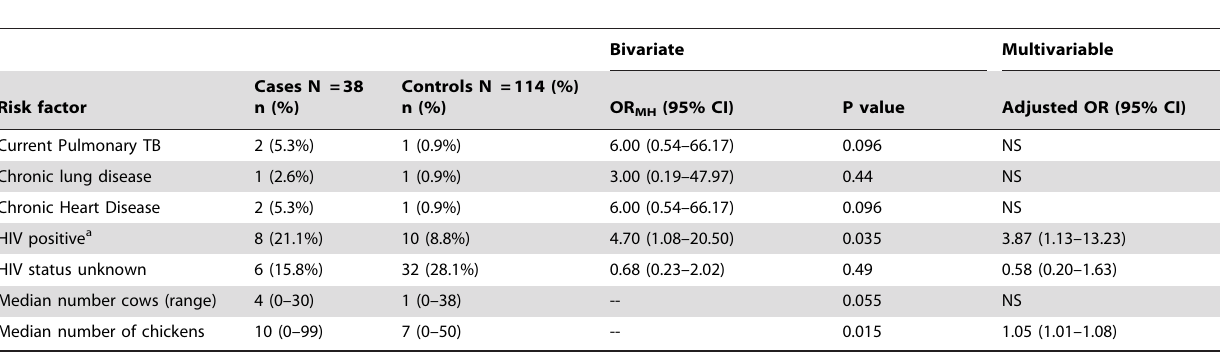
Table 4. Results of bivariate and multivariable analysis of risk factors for hospitalized influenza A, indicating the factors that were included in the multivariate model (p , 0.10), Bondo District, Kenya, 2007-9.